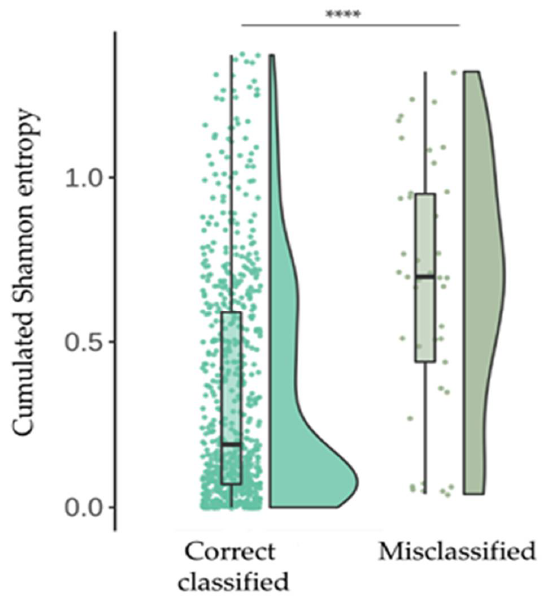
Figure 7. Raincloud plot showing the differences between correct classified and misclassified validation sites as a function of cumulated Shannon entropy (Shannon entropy 2002 + Shannon entropy 2019). Comparison made through the Wilcoxon-Mann-Whitney test with 10,000 sample Monte Carlo distribution approximations and with the entire validation dataset ( n = 708; **** p < 0.0001). The plot gives the data distribution (the ‘ cloud’ ), individual raw observations (the ‘ rain ’) and a boxplot for corrected and misclassified sites. In the boxplot, the horizontal bar in the center of the box is the median, and whiskers span 1.5 times the interquartile range.